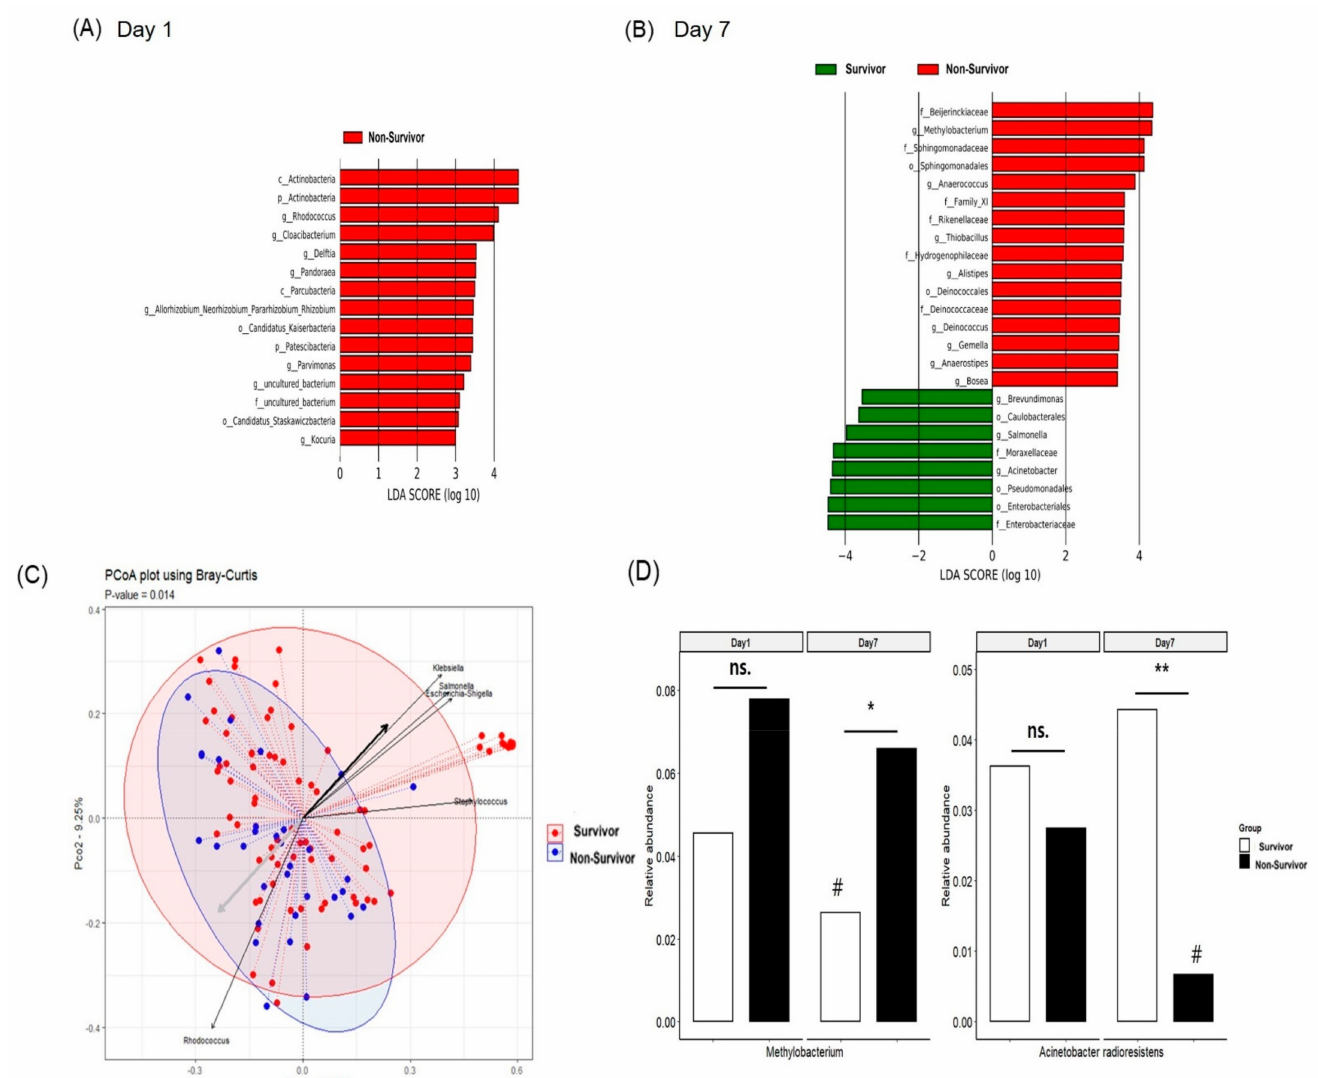
Figure 3. Plasma EVs of intubated patients according to 28-day mortality status. ( A ) LEfSe − based plasma MEV biomarkers at days one and ( B ) days seven ( C ) Visualization of the PCoA analysis on the Bray–Curtis dissimilarity index for the survivor group (red dashed lines) and non − survivor group (blue dashed lines). ( D ) Longitudinal changes in Methylobacterium and Acinetobacter radioresistance in the plasma EVs according to 28-day mortality status. EV: extracellular vesicle; LEfSe: linear discriminant analysis effect size; ROC: receiver operating characteristic; f: family; o: order; p: phylum; c: class; g: genus. # (day one vs. day seven, p < 0.05) * (survivor vs. non-survivor, p < 0.05), ** (survivor vs. non-survivor, p <